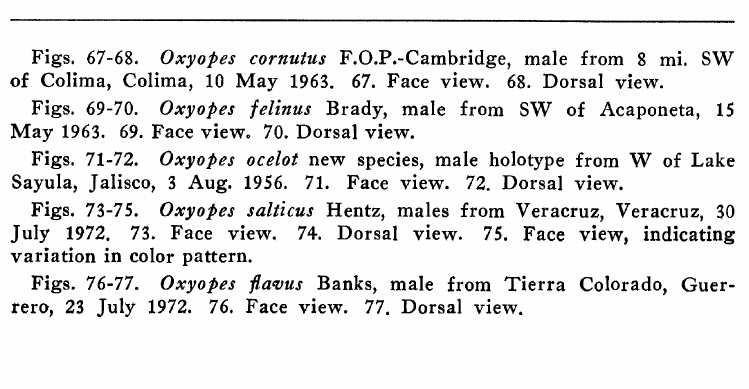
Figs. 67-68. Oxyopes cornutus F.O.P.-Cambridge, male from 8 mi. SW of Colima, Colima, 10 May 1963. 67. Face view. 68. Dorsal view. Figs. 69-70. Oxyopes felinus Brady, male from SW of Aeaponeta, 15 May 1963. 69. Face view 70. Dorsal view. Figs. 71-72. Oxyopes ocelot new species, male holotype from W of Lake Sayula, Jaliseo, Aug. 1956. 71. Face view. 72. Dorsal view. Figs. 73-75. Oxyopes salticus Hentz, males from Veracruz, Veracruz, 30 July 1972. 73. Face view. 74. Dorsal view. 75. Face view, indicating variation in color pattern. Figs. 76-77. Oxyopes flatus Banks, male from Tierra Colorado, Guer- rero, 23 July 1972. 76. Faee view. 77. Dorsal